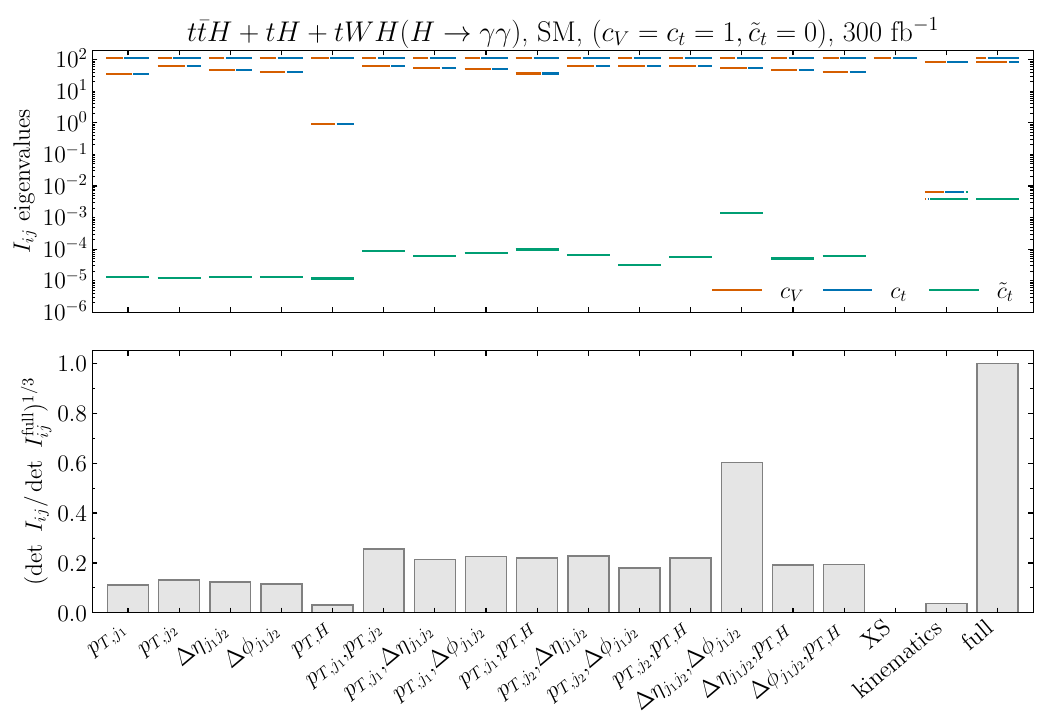
Figure 7 . Fisher information for top-associated Higgs production with H → γγ (for a luminosity of 300 fb − 1 ). The full information is compared to the information contained in several one- and two-dimensional distributions. The Fisher information is evaluated for the SM benchmark point ( c V = c t = 1 , ˜ c t = 0